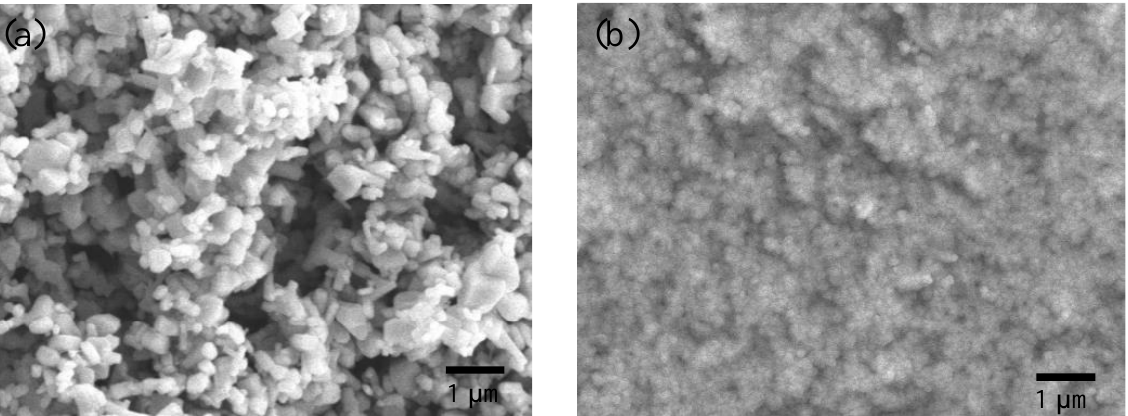
Figure 2. Top view SEM images of ( a ) origin-ZnO powder and ( b ) ZnO powder after ultrasonic grinding.